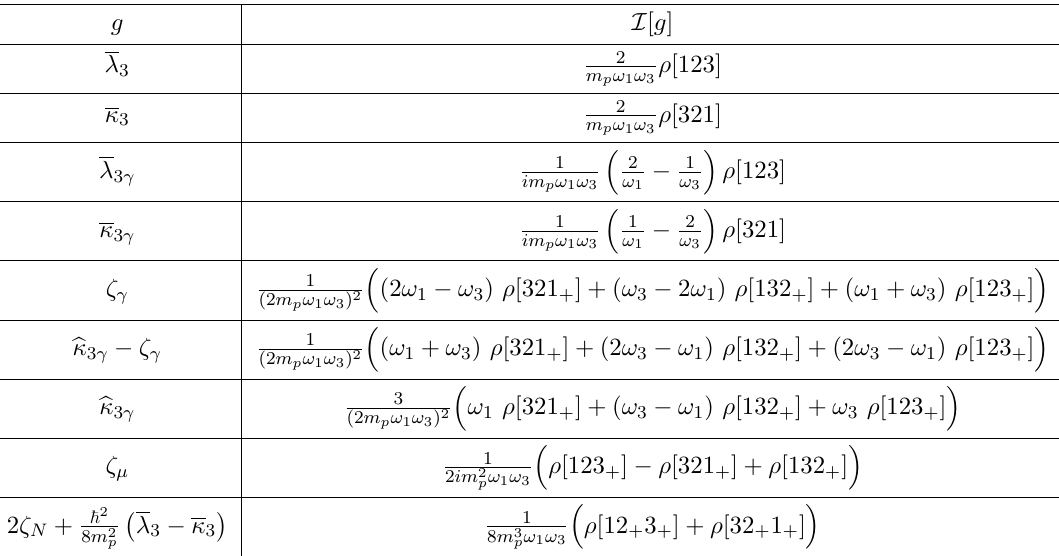
Table 7 . Coupling doublets/singlets under microscopic time-reversal (general